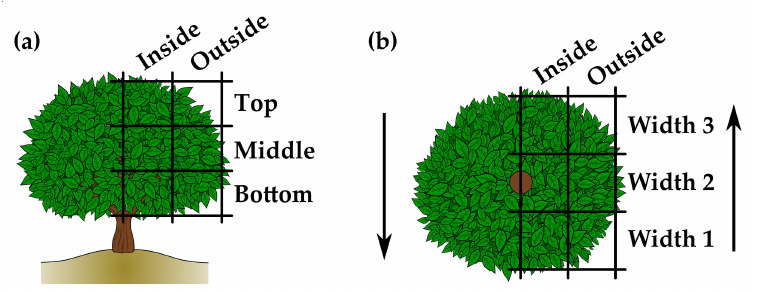
Figure 2. Quadrants of the canopy where water sensitive papers were placed. ( a ) Side view across the row and ( b ) top view of a standard citrus tree. Arrows indicate the forward direction of the airblast